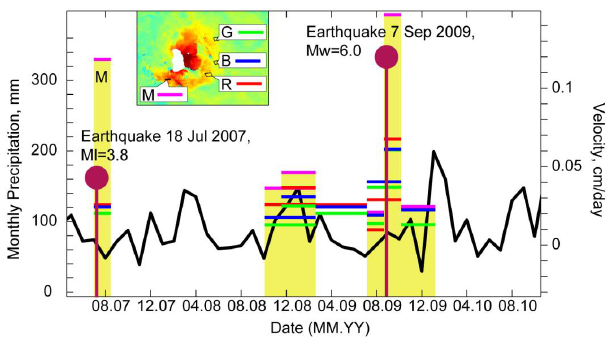
Fig. 9. Distribution of precipitation (black curve, left scale) based Figure 9. Distribution of precipitation (black curve, left scale) based on ECHAM5. The 852 on ECHAM5. The coloured lines (green, blue, red) and bar graphs coloured lines (green-blue-red) and bar graphs (magenta) show velocities (right scale) 853 (magenta) show velocities (right scale) within the area identified by letters “R”, “G”, “B”, “M” in Fig. 4a. within the area R-G-B-M in Figure 4 (A-H). 854